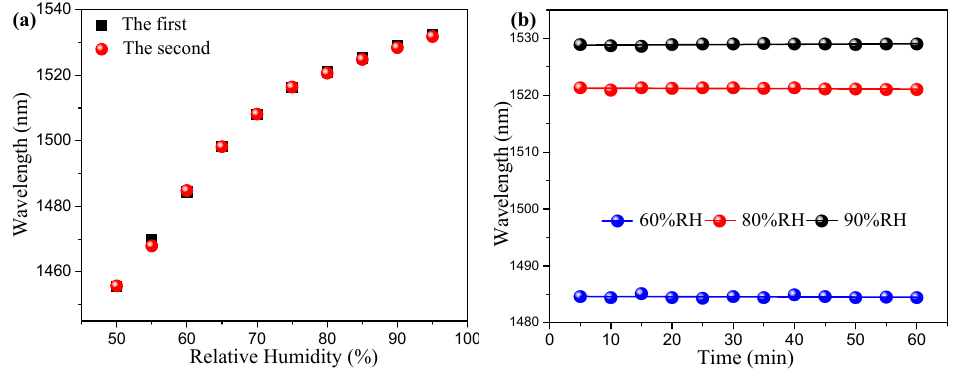
Figure 7. ( a ) The fitting line of the resonance dips under the ascending and descending humidity process. ( b ) Temperature response of the LPFGs without and with polymer coatings at different humidity. ( ► ) 66% RH without PEG/PVA composite film coating, ( ★ ) 70% RH without PEG/PVA composite film coating, ( ■ ) 60% RH with PEG/PVA composite film coating, ( ● ) 66% RH with PEG/PVA composite film coating, ( ▲ ) 70% RH with PEG/PVA composite film coating, ( ◄ ) 90% RH with PEG/PVA composite film coating.